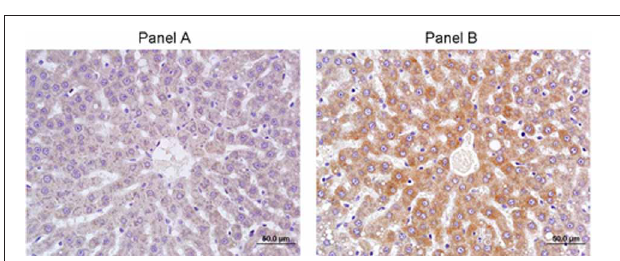
FIGURE 4 | Immunohistochemistry of Cyp1a1 in rat liver after 5 days of treatment. (A) Vehicle control. (B) 200mg/kg/day A-998679. Darker areas represent positive protein Cyp1a1 immunostaining.